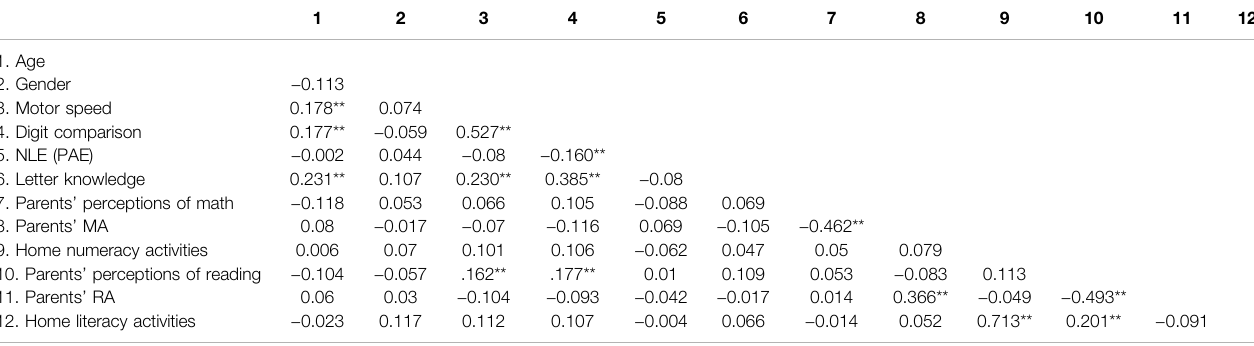
TABLE 2 | Correlations among control variables, HLE factors and children ’ s cognitive